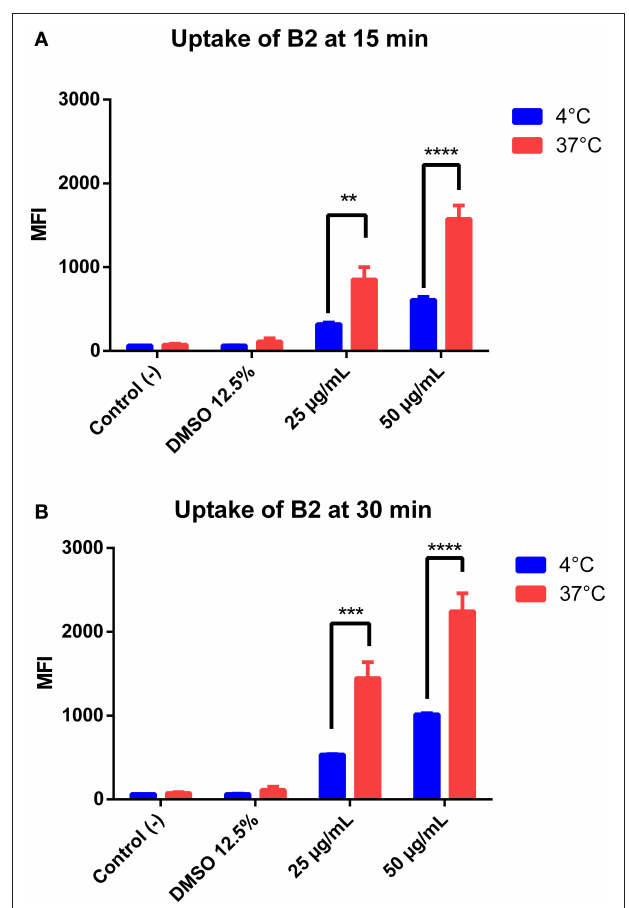
FIGURE 3 | Quantification of B2 uptake into HeLa cells. HeLa cells were incubated with different concentrations of B2 (25 or 50 µ g/mL), at 4 ◦ C or 37 ◦ C, for 15min (A) or 30min (B) . The mean fluorescence intensity (MFI) was determined by flow cytometry using a 350-nm excitation laser and a 520-nm detector. The statistical difference is based on the negative control (culture medium alone). A 2-way ANOVA was performed with Tukey’s posttest as a statistical analysis. Only relevant differences are depicted in the figure. ** p < 0.01, *** p < 0.001, **** p < 0.0001. n = 3 (biological triplicate).